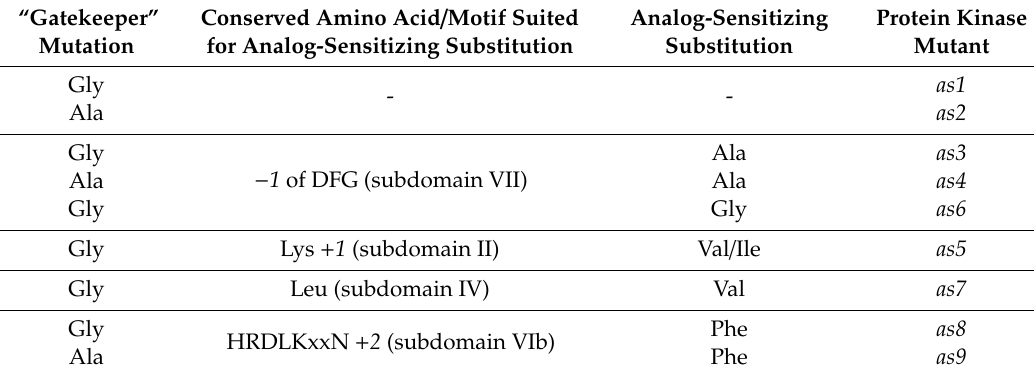
Table 1. Summary of each type of analog-sensitizing substitution identifiable in particular protein kinase subdomains that can be employed to create analog-sensitive ( as ) protein kinase mutants. The canonical sensitizing mutations convert a conserved bulky “gatekeeper” residue into either Gly ( as1 protein kinase mutant) or Ala ( as2 protein kinase